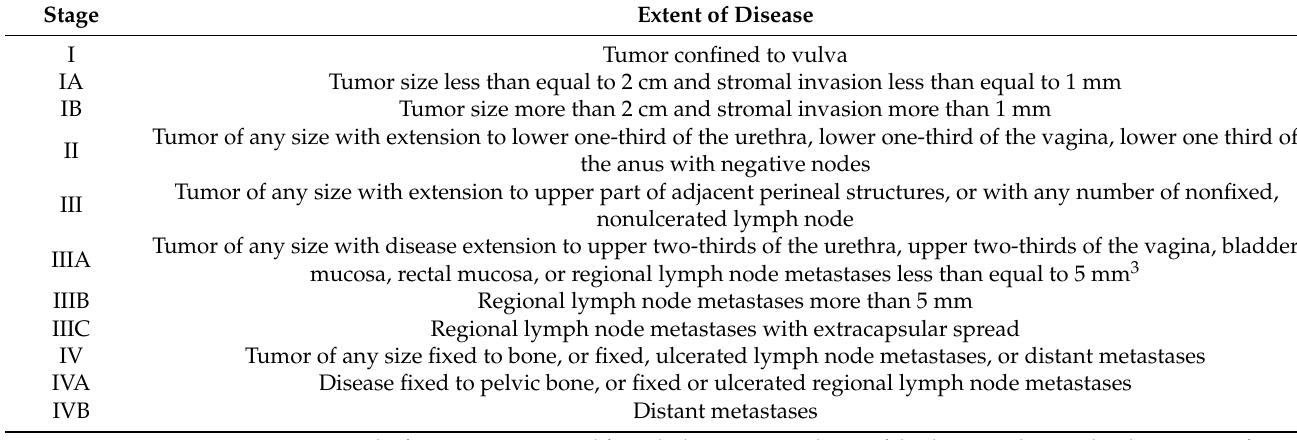
Table 13. New (2021) FIGO staging for carcinoma of the vulva.